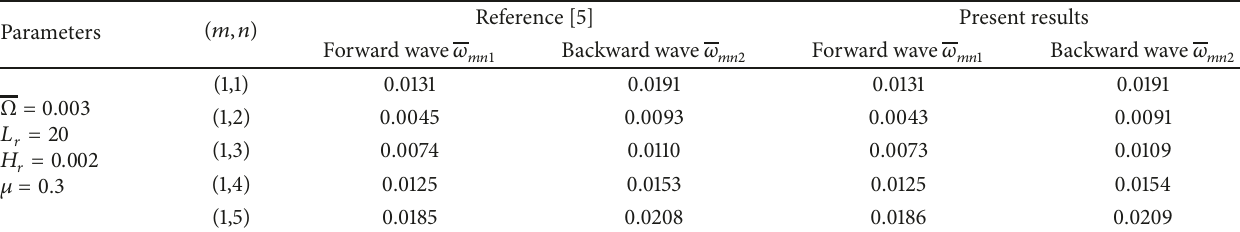
Table 1: Nondimensional frequency parameters of previous and present studies.